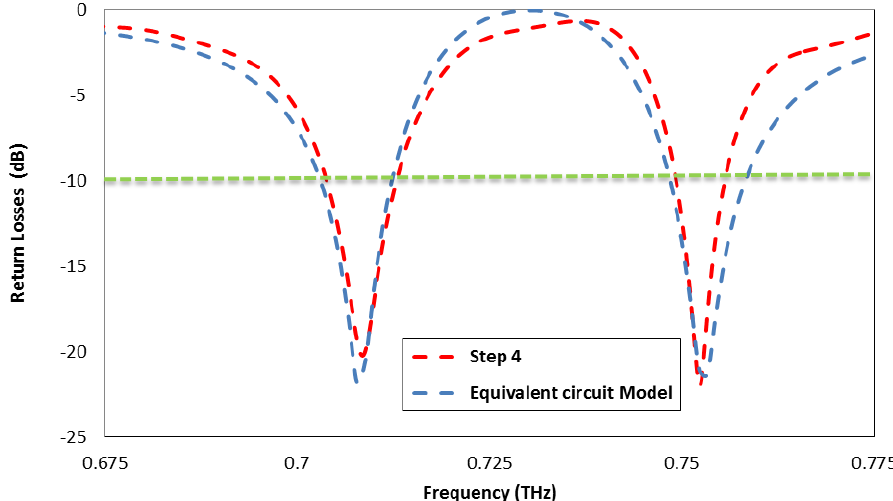
Figure 7. Return losses of dual-band Step 4 THz antenna and equivalent circuit model.